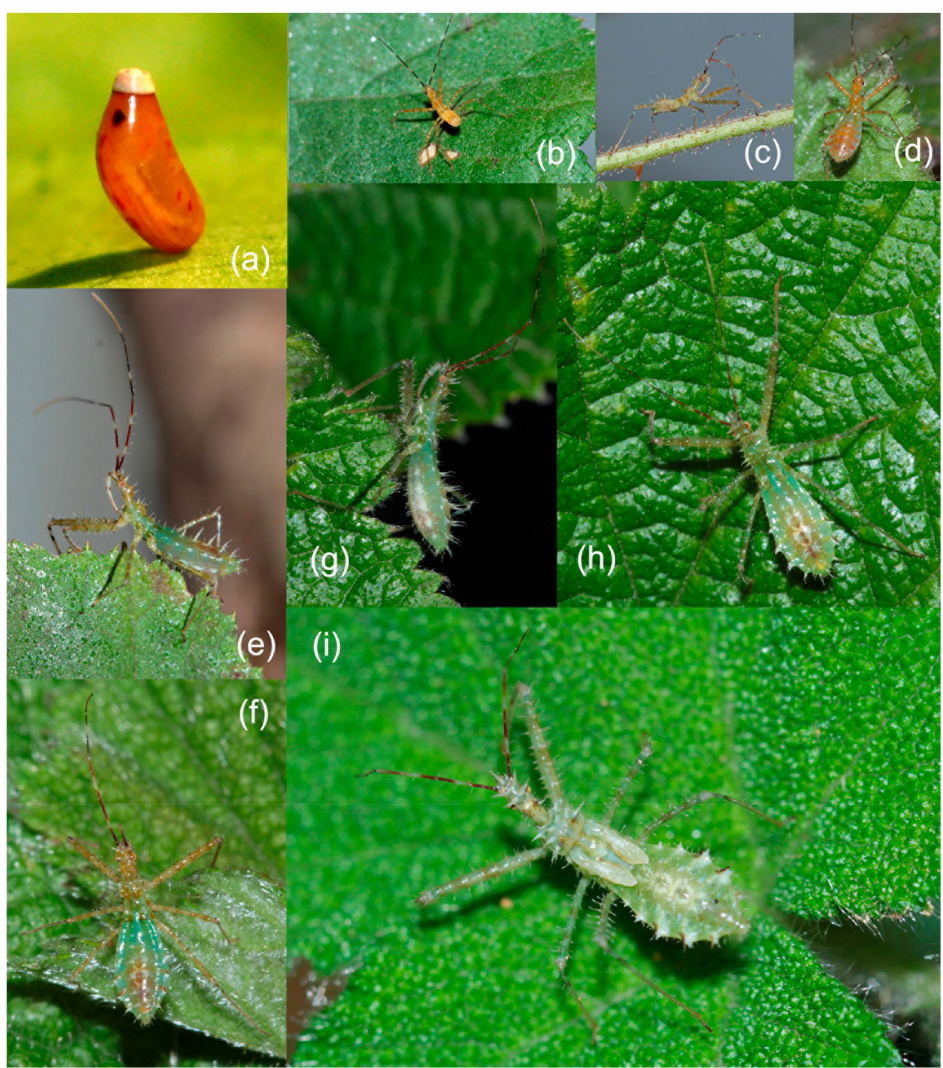
Figure 5. Sclomina erinacea Stål, 1861, GZLS. ( a ) egg; ( b – i ) nymph. ( a ) reddish brown egg before hatching; ( b ) first instar; ( c , d ) second instar; ( e , f ) third instar; ( g , h ) fourth instar; ( i ) fifth instar. The first instar nymph has a body that is pale yellowish brown to reddish brown, femora with dark brown tubers, tibiae that are pale greyish brown, with the basal part of tibiae having blackish brown annular markings, and the apical part of the tarsus is black; first to third antennal segments and basal part of the fourth are blackish brown (except for two annulations in the middle part of the first segment, one annulation in the middle part of the second, which are white to yellowish), most of fourth segment is reddish brown (except the basal part); the eyes are red. The body is covered with pale longer setae; the first antennal segment and the basal half of the second are sparsely covered with longer setae, the fourth segments with yellowish brown short setae (except the basal part); legs are sparsely covered with yellowish brown setae of various lengths. Head, thorax, femora, and abdomen dorsally have spines and tubers; the first antennal segment has several small tubercles. Body length is 2.00–2.50 mm (Figure 5b). The second instar nymph is similar to the first instar in coloration and structure, except the basal part of the abdomen is green, and the spines and tubers on the surface of the body become more distinct and thickened. Wing pad differentiation is not distinct. Body length is 3.30–3.42 mm (Figure